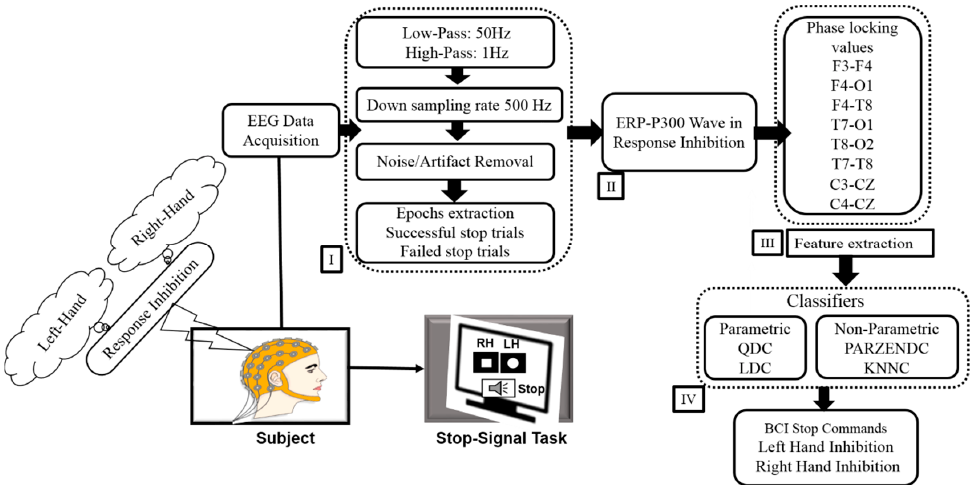
Figure 2. The system architecture of the proposed hierarchical classification model. (I) EEG signal preprocessing steps. (II) Event-related potential (ERP)-P300 wave during LHR and RHR inhibitions. (III) Phase blocking value (PLV) between two EEG signals during LHR and RHR inhibitions. (IV) Parametric (LDA, QDA) and non-parametric (PARZENDC, KNNC) classifiers, which are the